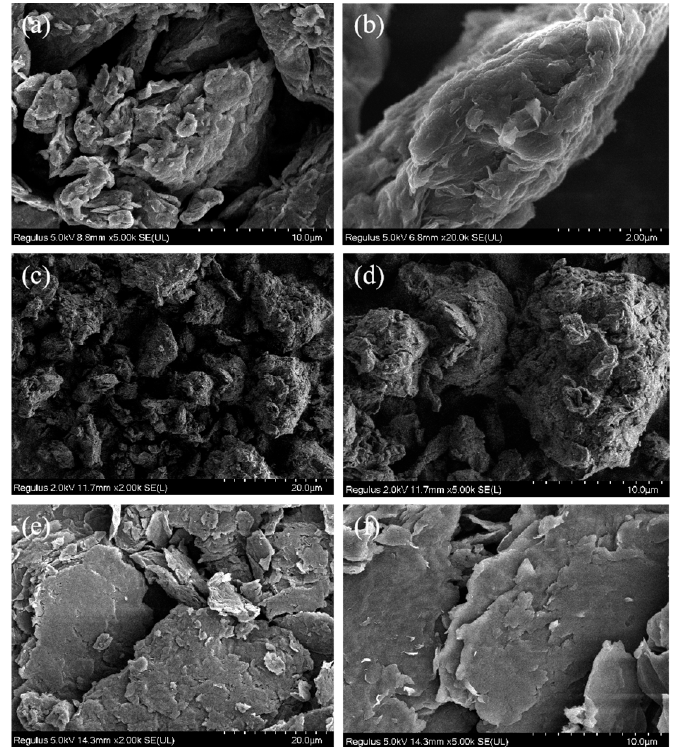
Figure 5. SEM images of GO ( a , b ), TGO ( c , d ) and GA ( e , f )